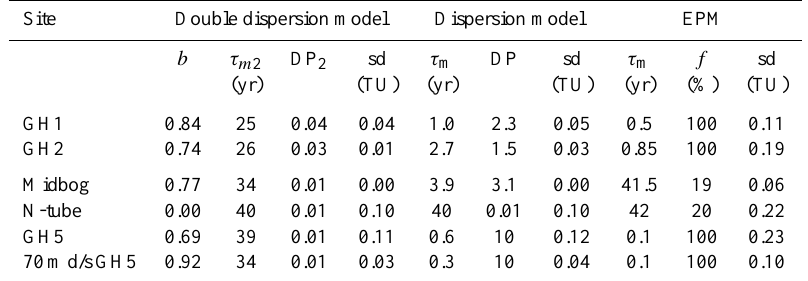
Fig. 3. Variation of tritium, CFC, silica and oxygen-18 concentrations in waters with distance from the head of the wetland in GH5 catchment. The dotted vertical lines show approximately where the stream begins. Table 2. Best-fit parameters for simulation models (double dispersion model (DDM), dispersion model (DM), and exponential piston flow model (EPM). (The parameters of the young component of the DDM are τ m 1 =0.1 year, DP 1